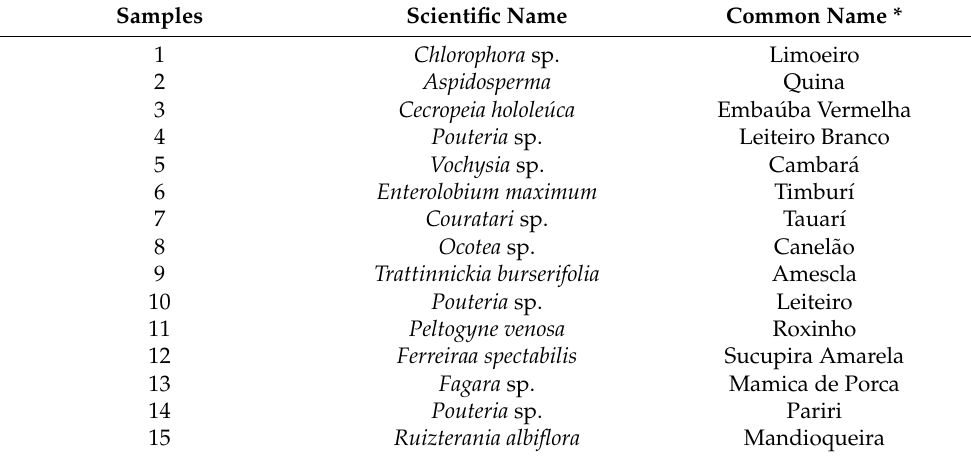
Table 1. Typical woods from Amazon biome used in this study. * The common names (in Portuguese) are those by which they are known in the Amazon